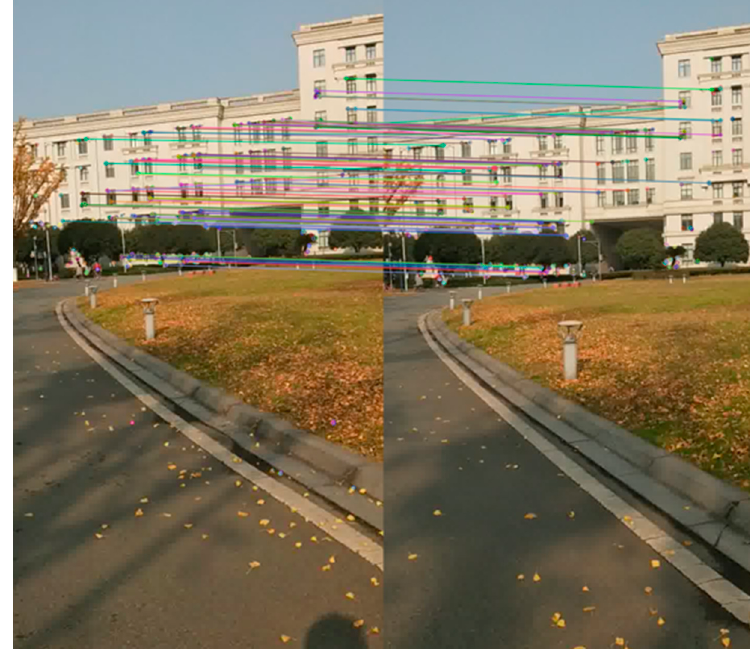
Figure 14. An example of ORB feature matching (rejected by error).